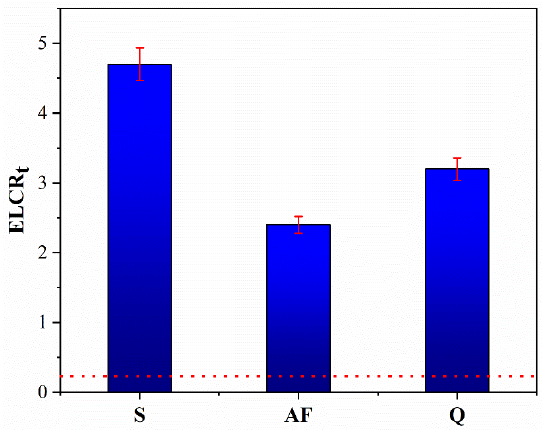
Figure 9. The average variation of total excess lifetime cancer risk (ELCRt) with granitoids type: syenogranite (S), alkali feldspar granite (AF), and quartz syenite (Q), the red line means the permis- sible limit.